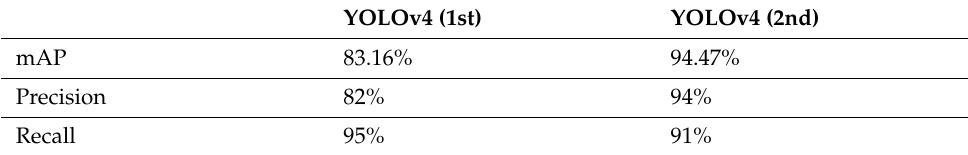
Figure 9. The tool LabelImg is used to create the training dataset. Table 7. Performance of the 1st and the 2nd version of YOLOv4.